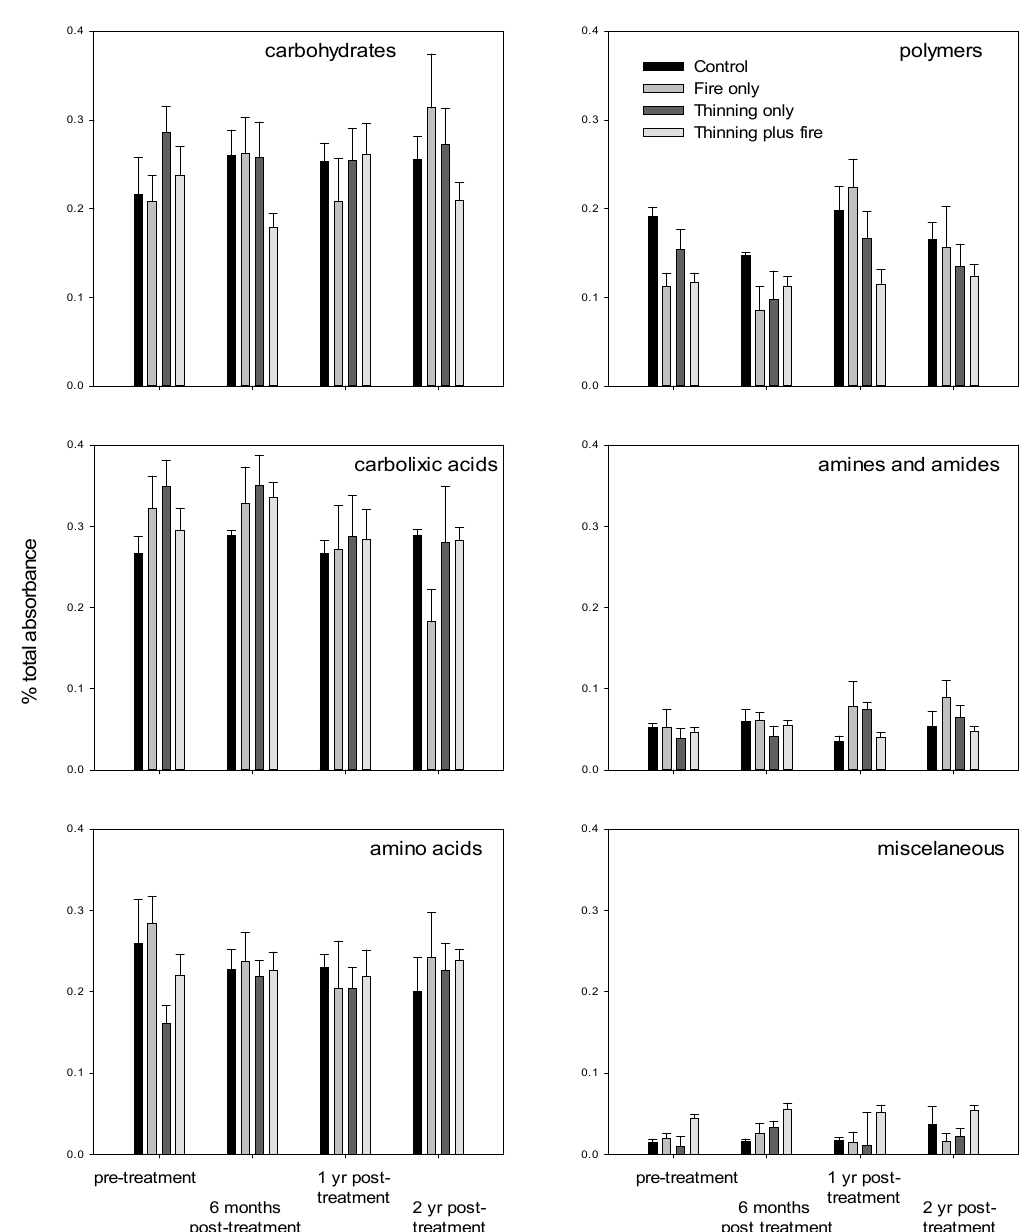
Figure 4. Community-level physiological profiles for bacteria (Biolog™ EcoPlate) in surface mineral soil (0–5 cm) 1-year post-treatment at the Southwestern Plateau, Fire and Fire Surrogate study site. Data shown are the observed mean catabolic activity + SE ( n = 3) by substrate guild, normalized to the total catabolic activity in that treatment. No significant differences ( α = 0.05) were found among the treatments based on a multi ‐ response permutation procedure.